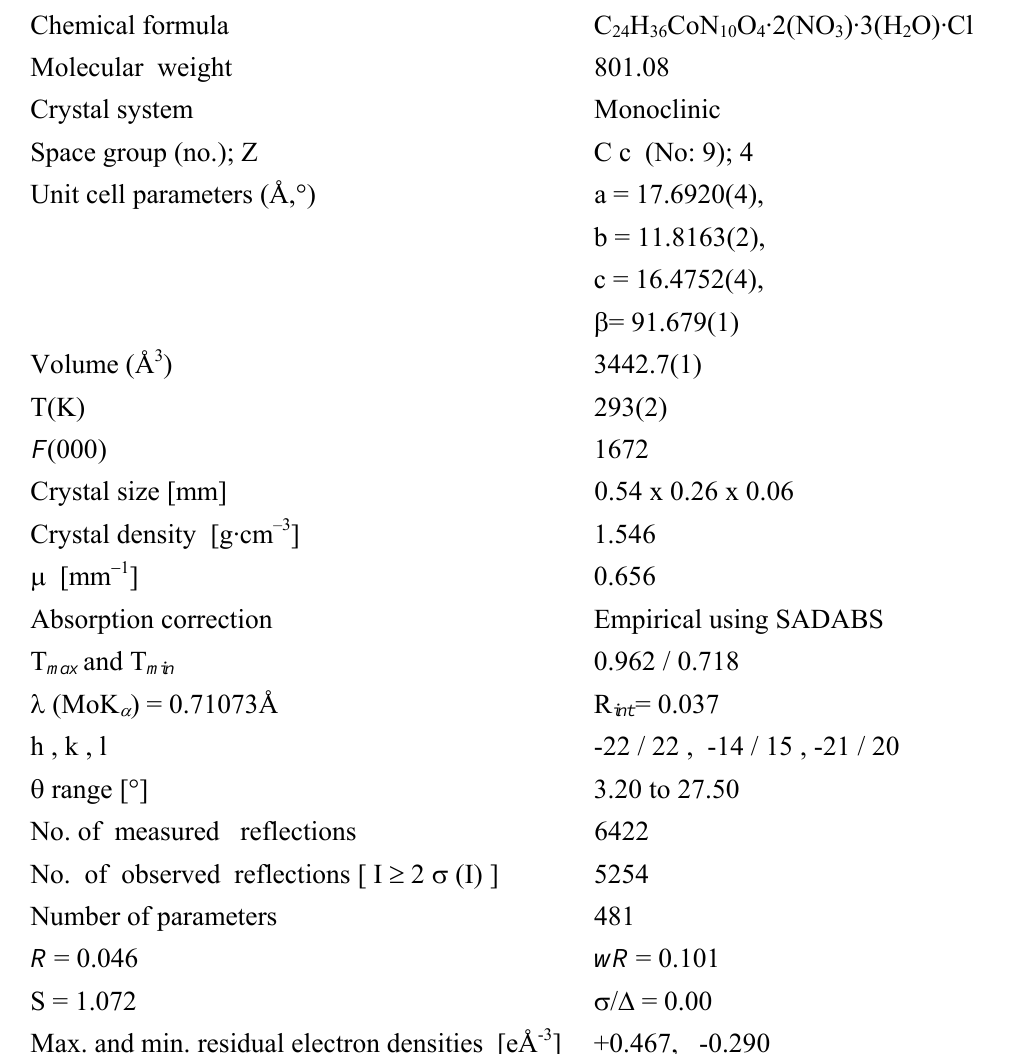
Table 1. Summary of crystal data and structure